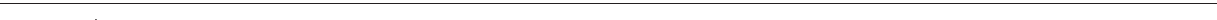
FIGURE 1 | decisions by physicians, such as recommending potential treatments (see bottom of item 4) and suggesting conducting further diagnostic tests or analyses (from 4 to 1). (B) Semi-automated disease diagnosis and monitoring. Individual data are de-identified, encrypted, and transferred remotely via the cloud to secured data centers—where population-level disease analyses are performed. The individual data are then analyzed and compared with the population features to generate an automated preliminary diagnosis report. Should red flags be raised, the report is passed on to a medical professional. The medical professional looks at both the report and the individual-specific data to offer medical recommendations or to arrange for an on-site visit or remote consultation (e.g., telemedicine), depending on which further tests are anticipated. This process continues between an individual’s periodic health checks to ensure earliest possible detection of symptoms and to compensate for long consultation intervals when regular assessment is too expensive or inconvenient. (C) Automated deep-geno/phenotyping. The digital health applications facilitate ensemble-learning, where multivariate genotypic and phenotypic (e.g., digital biomarker, imaging, and molecular diagnostics) data are combined to provide rich subject-specific and group-level information, which are used to position individuals within a relevant population or to predict outcomes for individuals, based on population norms. (D) The marriage between personalized health care and public health. There is a powerful interdependent and